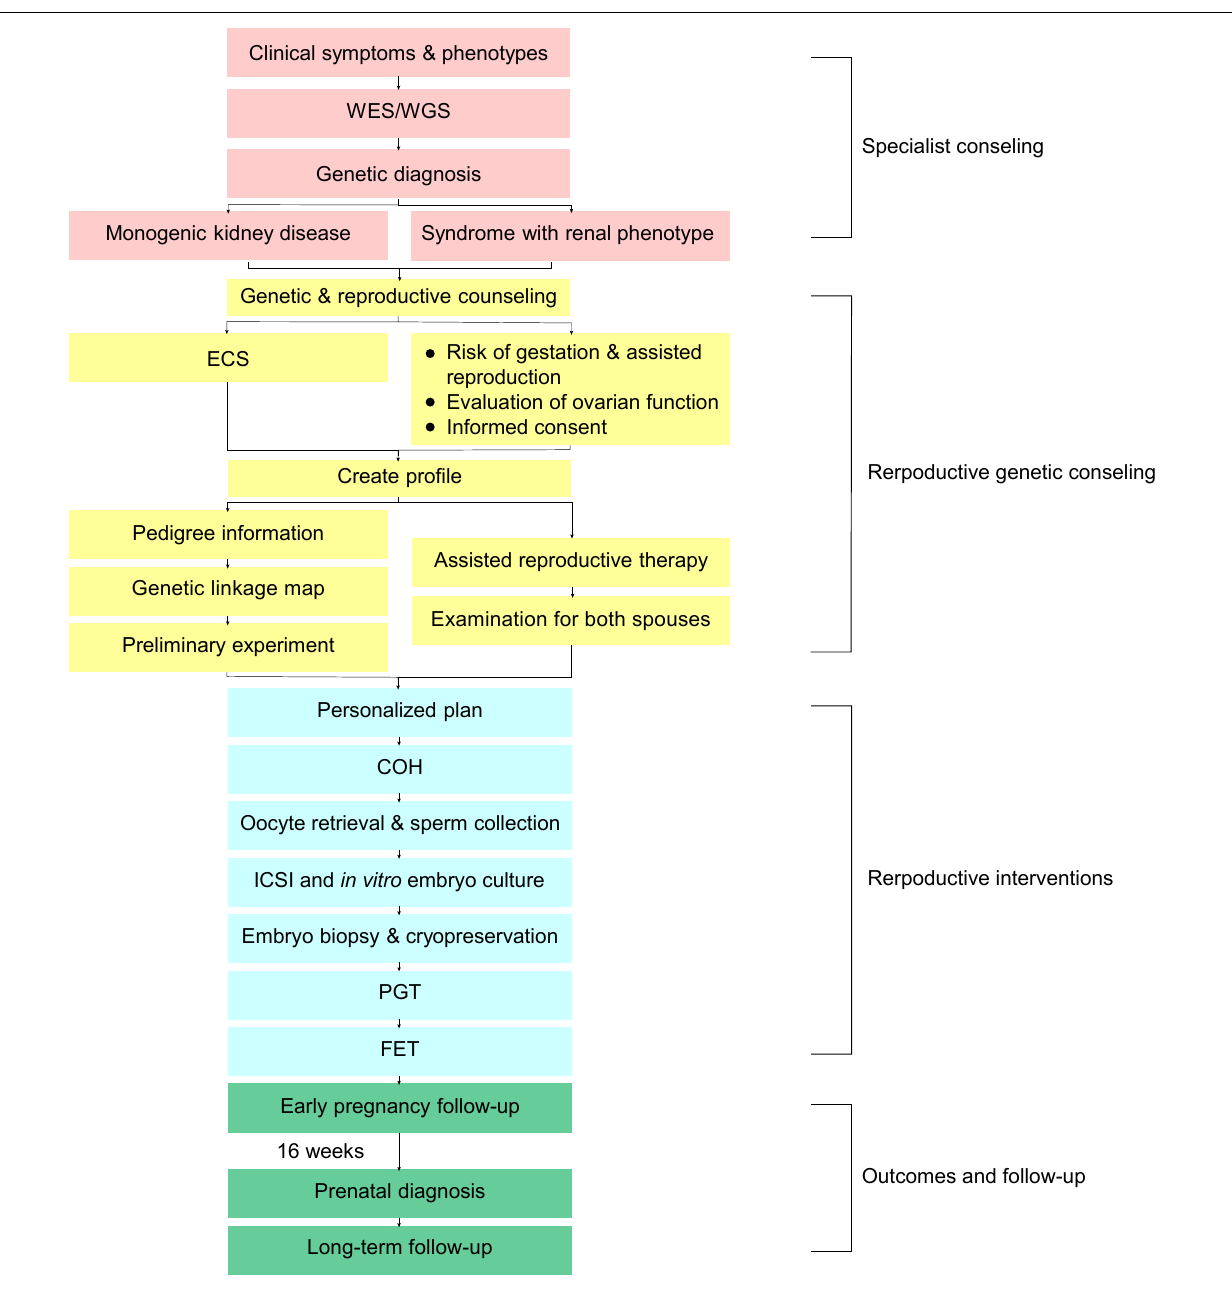
FIGURE 1 | Flowchart showing the preimplantation genetic testing for monogenic disease (PGT-M) procedures and follow-up of couples with genetic kidney disease. WES/WGS, whole exome sequencing/whole genome sequencing; ECS, expanded carrier screening; ICSI, intracytoplasmic sperm injection; COH, controlled ovarian hyperstimulation; PGT, preimplantation genetic testing; FET, frozen-embryo